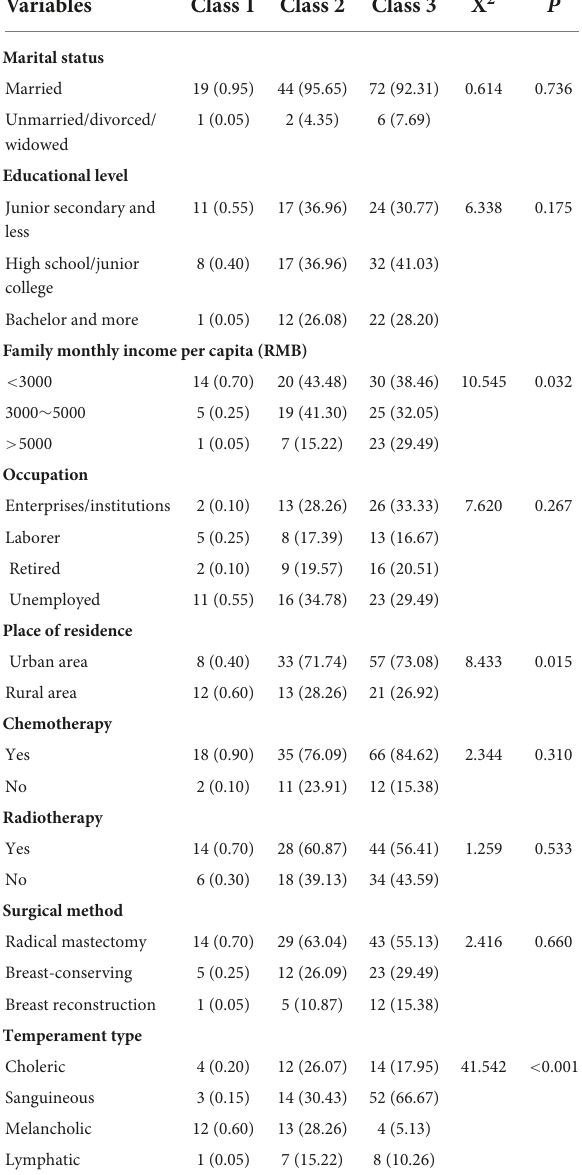
TABLE 2 Single-factor analysis of influencing factors of social avoidance trajectories ( n =